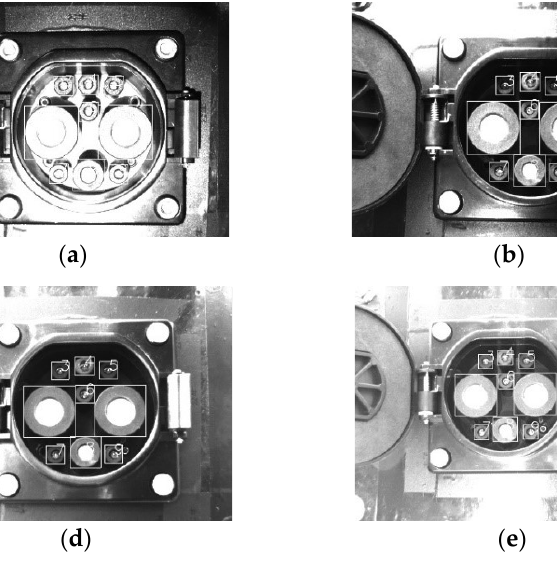
Figure 10. The recognition effect results in different scenarios in the aiming phase. ( a ) Indoor sunny day/overcast day time 1/time 3. ( b ) Outdoor sunny day time 1/time 3. ( c ) Outdoor sunny day time 2. ( d ) Outdoor overcast day time 1/time 3. ( e ) Outdoor overcast day time 2. ( f ) Time 4.